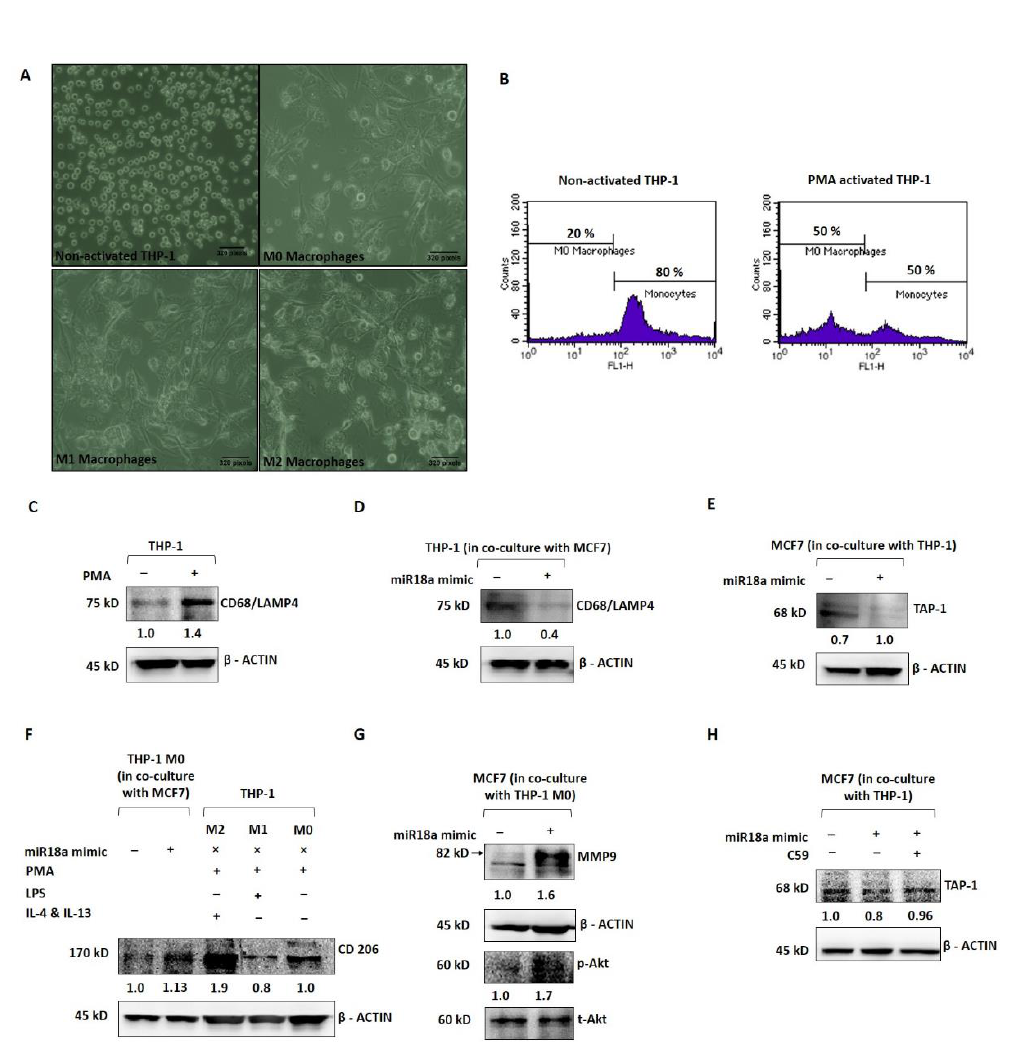
Figure 3. miR-18a over-expression mediates immune suppression in monocytic cell line THP-1 and promotes invasive and survival ability in ER+ breast cancer cells. ( A ) Morphological changes to THP-1 on PMA induction and morphological changes to M0 macrophages on treatment with LPS, IL-4, and IL-13, respectively, to facilitate differentiation to M1 and M2 macrophages, respectively. ( B ) Immunophenotyping by flow cytometry to assess level of expression of CD14 in THP-1 with and without PMA induction. ( C ) Expression levels of CD68 in THP-1 with and without PMA induction. ( D ) Expression levels of CD68 in THP-1 cells in co-culture with MCF7-miR-vehicle and MCF7-miR-18a-mimic. ( E ) Expression levels of TAP-1 in MCF7-miR-vehicle and MCF7-miR-18a-mimic co-cultured with THP-1. ( F ) Expression levels of CD206 in MCF7-miR-vehicle and MCF7-miR-18a- mimic co-cultured with THP1, control M2, M1, and M0 macrophages. ( G ) Expression levels of MMP9, p-Akt, and total-Akt in MCF7-miR-vehicle and MCF7-miR-18a-mimic co-cultured with THP1. ( H ) Expression levels of TAP-1 in MCF7-miR-vehicle, MCF7-miR-18a-mimic and MCF7-miR-18a- mimic-C59 inhibited, co-cultured with THP1. Values are mean ± S.E.M. ( n = 3). Statistical analysis was performed by the Student’s t -test compared with the mimic negative